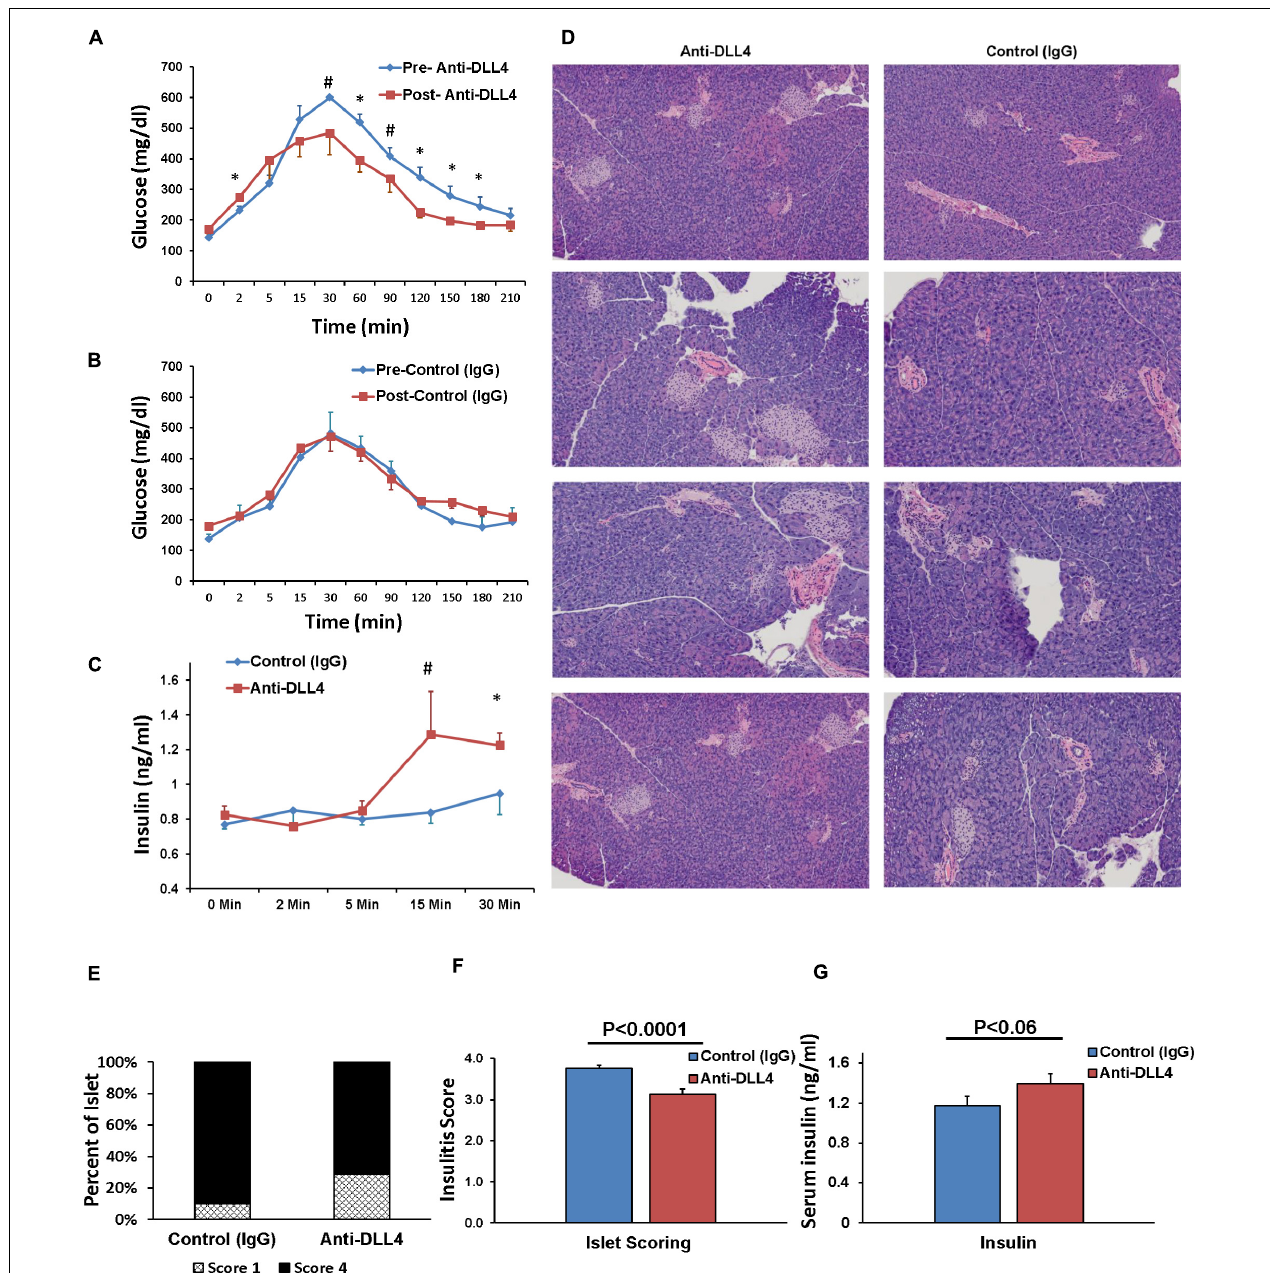
FIGURE 4 | Anti-DLL4 improves glucose tolerance, protects islet architecture and ultimately improves insulin secretion. Glucose tolerance test (GTT) readings pre-treatment and post 1 month treatment of (A) anti-DLL4 and (B) control IgG treated mice ( n = 4 mice per group). Simultaneously, (C) glucose stimulated plasma insulin synthesis (GSIS) were measured at 0, 2, 10, and 30 min post glucose challenge in both anti-DLL4 and control IgG treated mice (4 mice per group). Statistical significance was determined at P < 0.05 (*), means with different superscript (#) have an approaching statistical difference ( P = 0.06 to P < 0.1) between the group. (D) Pancreases were isolated from mice and fixed in 10% buffered formalin. Pancreases sections (2- µ m thickness) were stained with hematoxylin and eosin for morphological analysis, insulitis score-degree for histological identification, localization of lymphocytic infiltration and for classification of islets with disrupted architecture. Anti-DLL4 treated mice rescue the pancreatic islets (E,F) in humanized T1D mice. In totality, anti-DLL4 treatment improves the plasma insulin secretion ( P < 0.06) as compared to control IgG treated group (G)